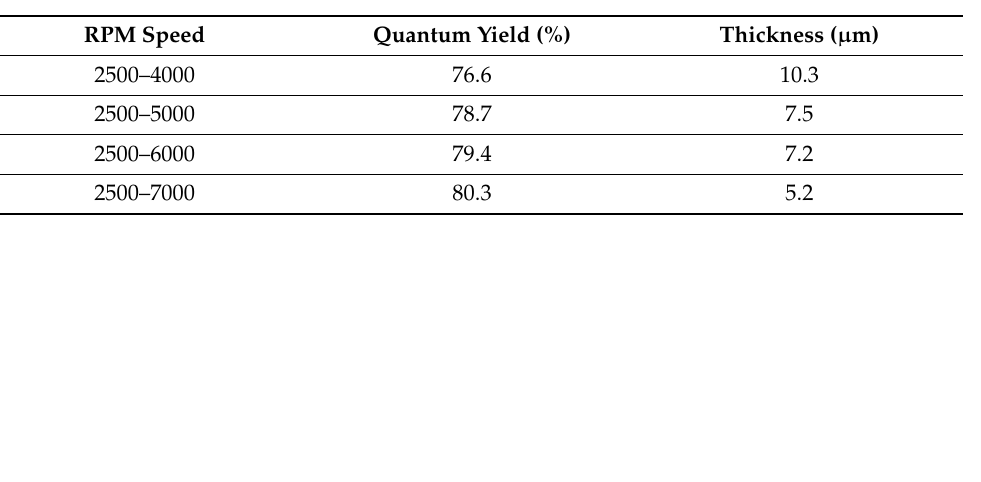
Figure 5. ( a ) Absorption profile at varied concentrations of ( a ) DCJTB, ( b ) coumarin-6, ( c ) absorption profile of red fluorescent film at different PVB concentrations, ( d ) optical appearance of the fluorescent film with variation in PVB concentration, and ( e ) cross-sectional image of the fluorescent film taken under SEM. Table 3. Variation in quantum yield and thickness with the spin speed of the thin film